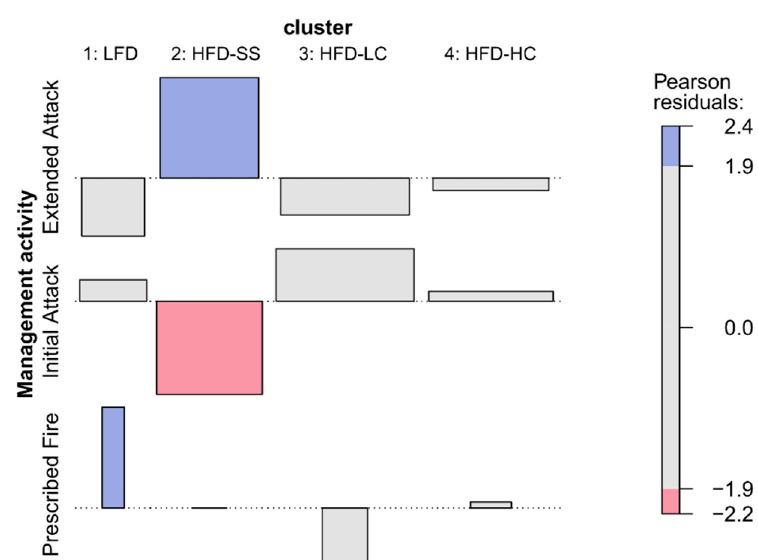
Figure 8. Association plot showing deviations from independence between the type of resource involved in the entrapment and cluster type. Light and dark blue shading corresponds to significant positive associations, α = 0.05 and α = 0.0001 respectively, while light red indicates a significant negative association ( α = 0.05) and grey is non-significant. The height of each rectangle is proportional to the corresponding Pearson residual (legend values) while the width is proportional to the square root of the expected count (i.e., wider indicates a higher expected value). The type of resource includes Hand Crews (HC) and multiple types (ML). Note that Equipment comprises non-dozer related firefighting equipment including tractor plows.